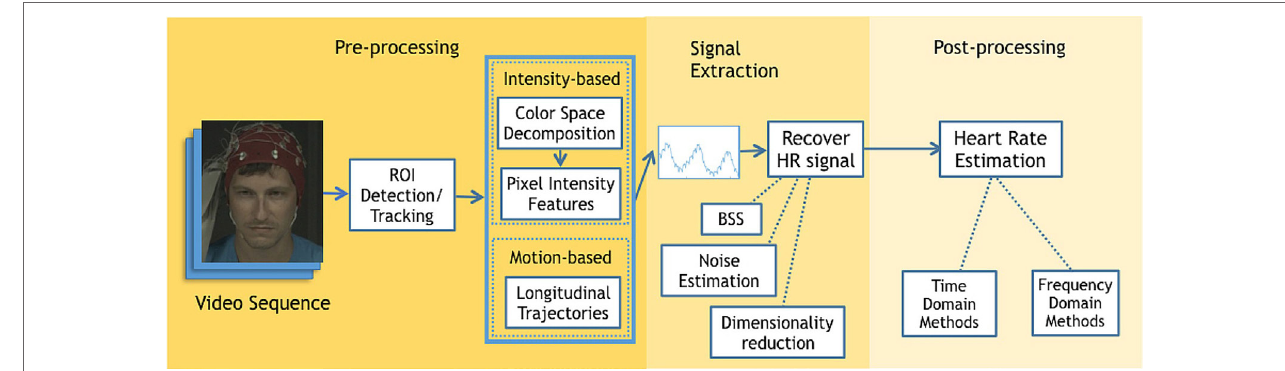
FigURe 2 | General schematic diagram for remote heart rate (HR) detection from face